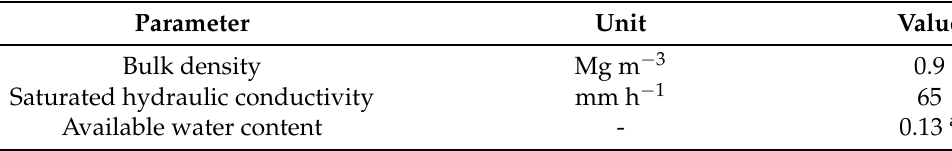
Table A2. Parameters used to adjust drought flow.